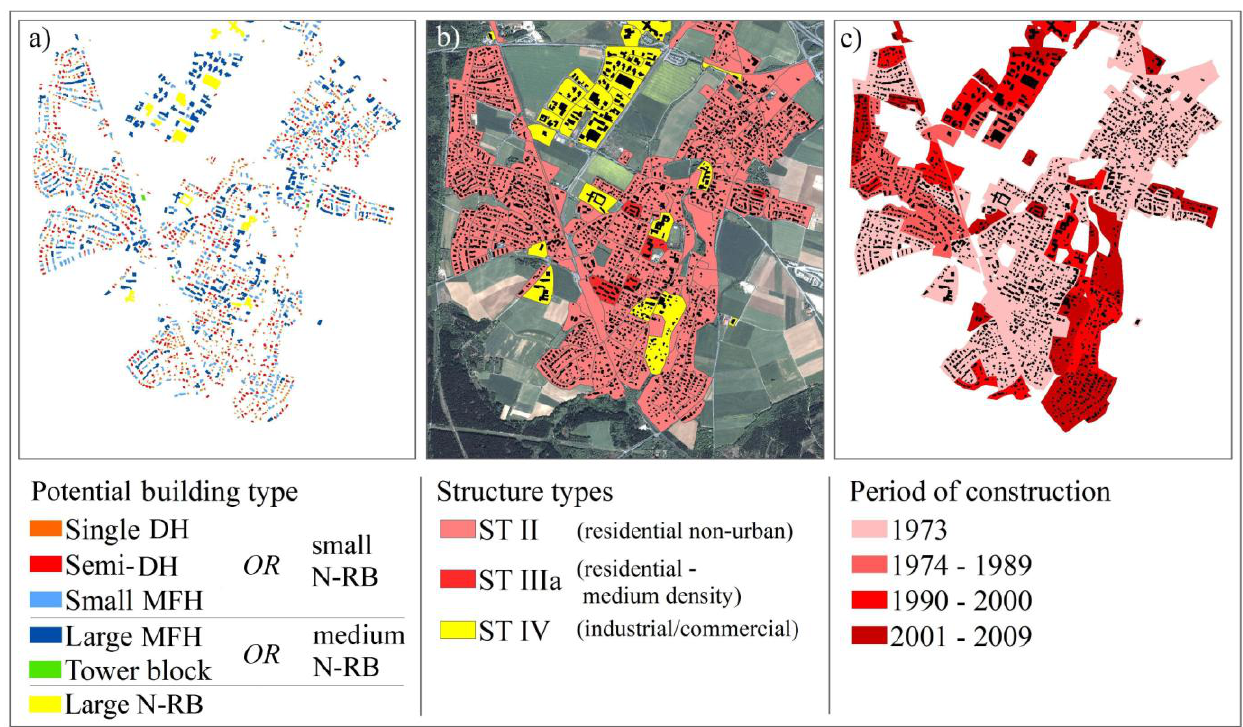
Figure 2. Derived information layers for an energy-relevant characterization of the settlement area. (a) Classified potential building types for individual buildings, (b) classified structure types on building block level, (c) derived periods of construction on building block level.